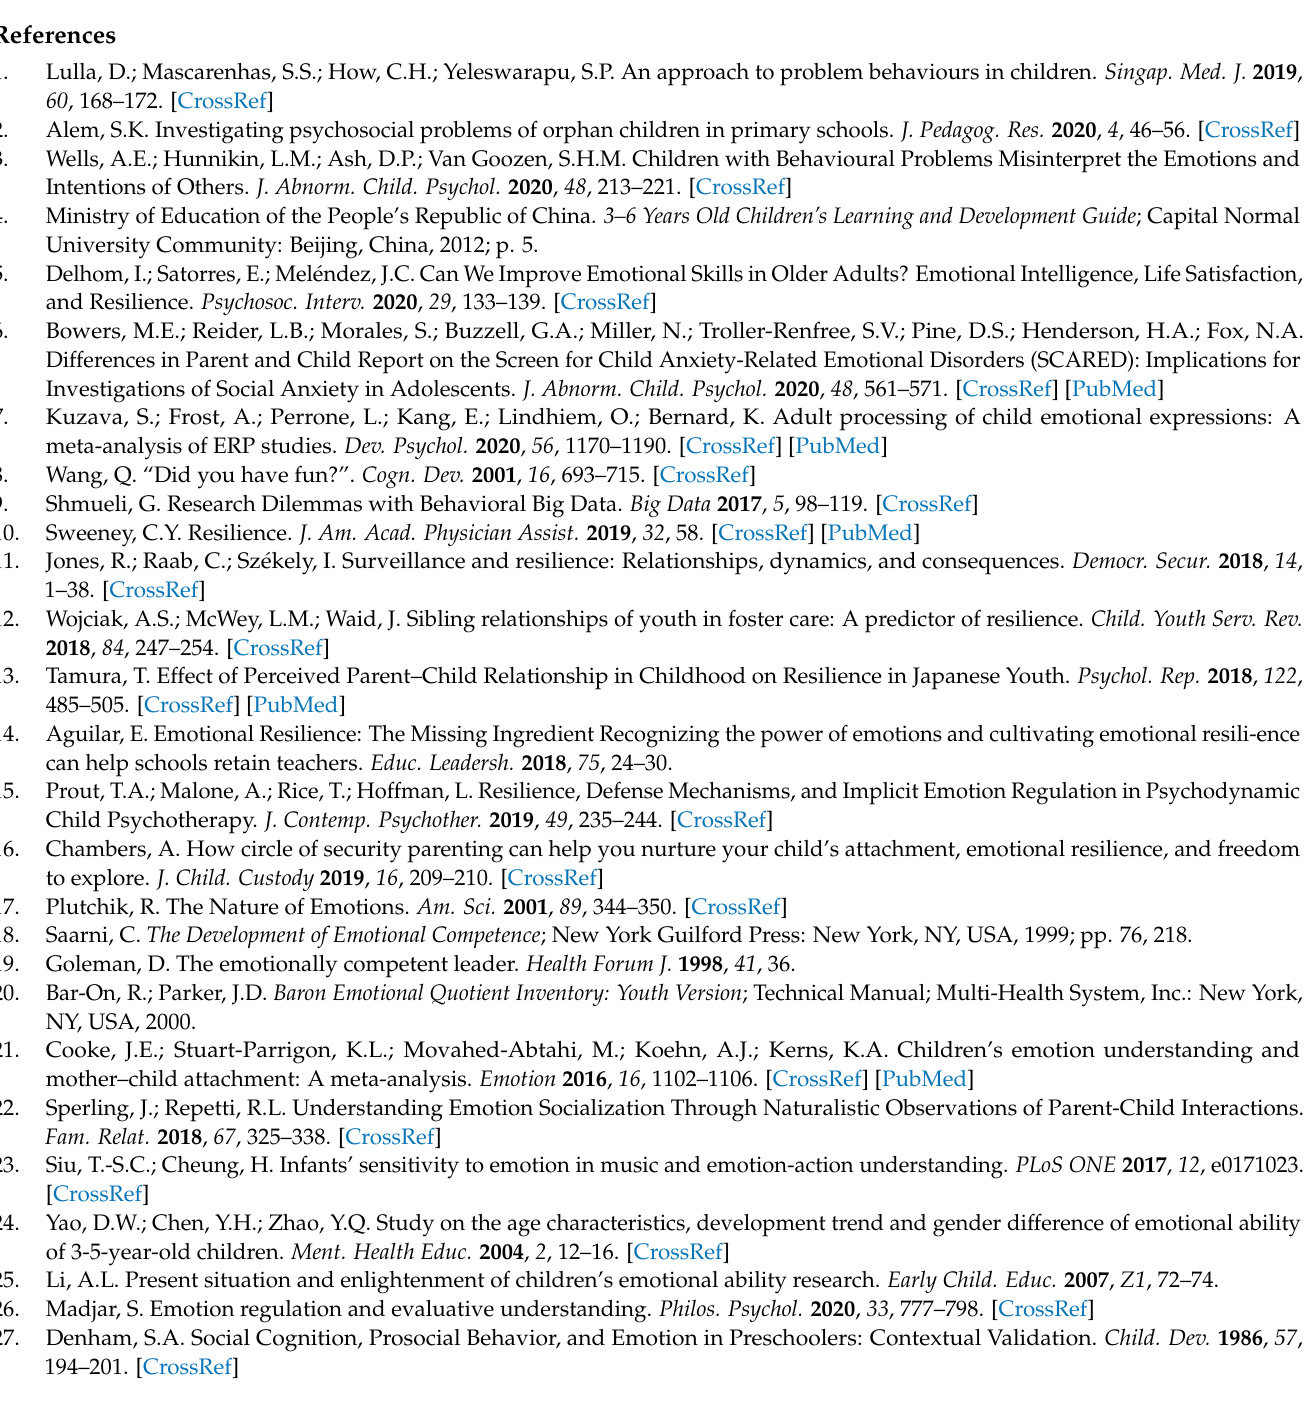
Table A3. Children’s resilience assessment scale (for parents). No. Items Never → Always: 1 → 5 1 Listen to or respect others. 1 Show confidence in your 1 2 2 abilities (e.g., “I can do it”). Lose temper. Try again and again when